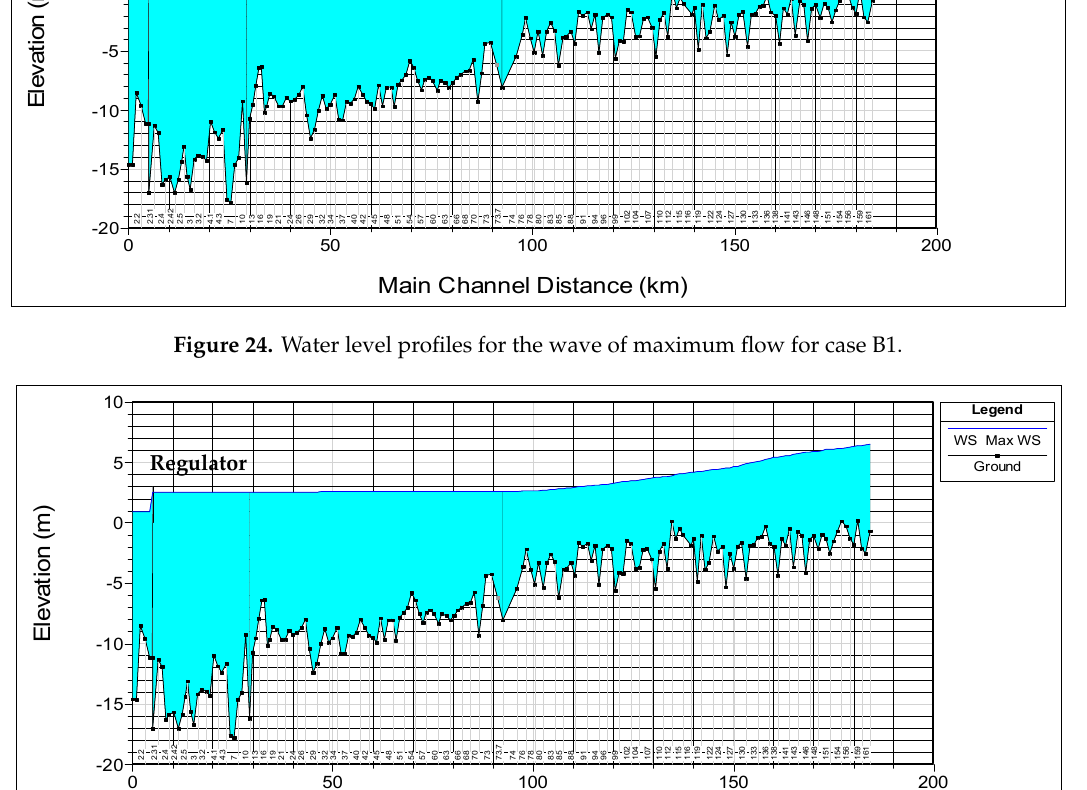
Figure 27. Maximum water level profiles of the 200 m 3 /s wave for all considered cases.